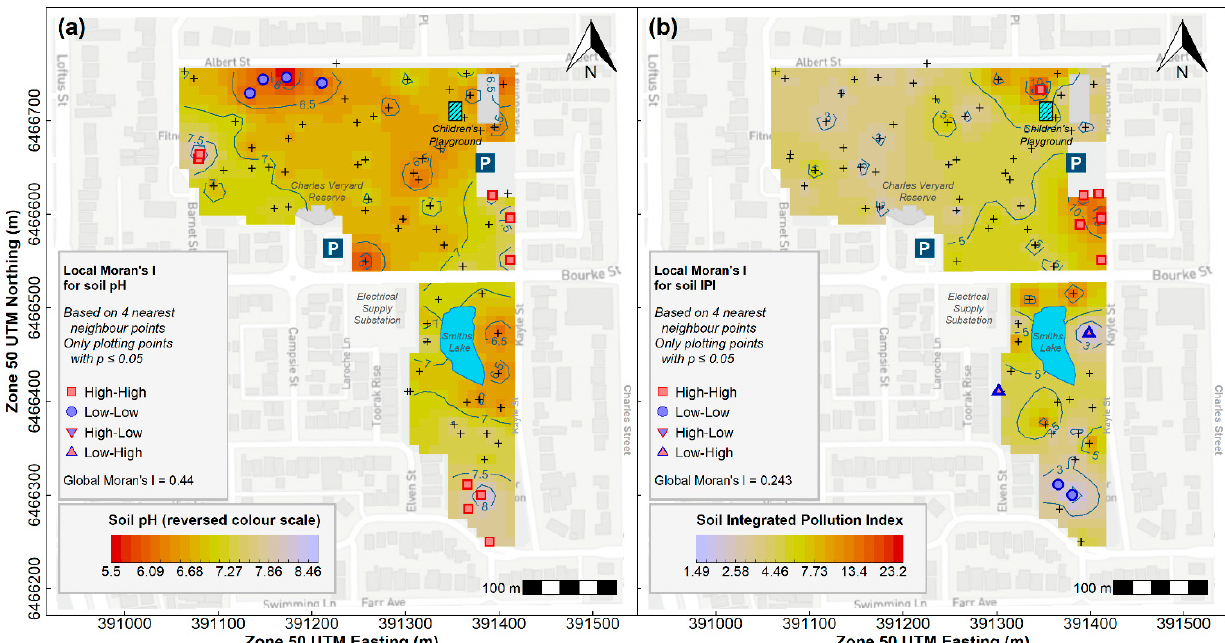
Figure 6. Spatial distributions of ( a ) pH and ( b ) Integrated Pollution Index (IPI) in soil across Smith’s Lake and Charles Veryard Reserves, interpolated by inverse distance weighting with significant local spatial autocorrelations (Local Moran’s I ≤ 0.05) indicated with filled symbols. All sample points shown by + symbols.